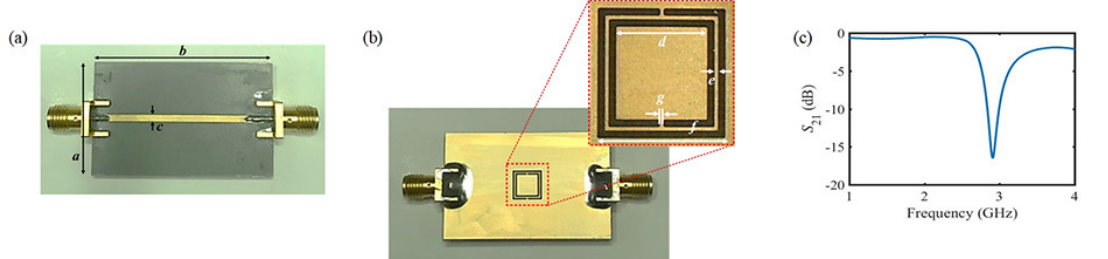
Figure 2. Simulation results of the proposed sensor. ( a ) electric field distribution at the resonant frequency ( λ /15 above the substrate); ( b ) modelling of proposed sensor and fluidic channel as experimental condition; ( c ) transmission characteristic with and without the fluidic channel.